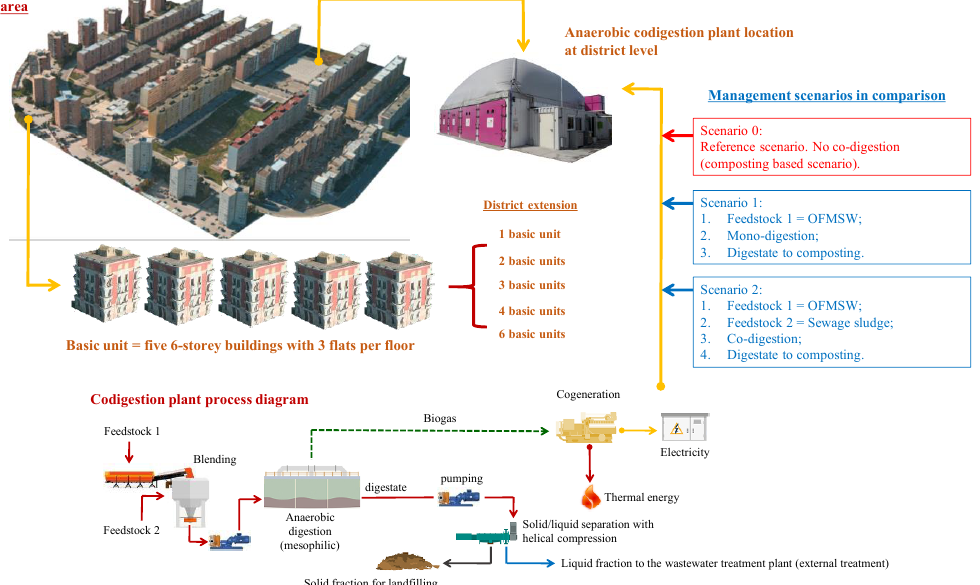
Figure 1. Management scenarios in comparison.